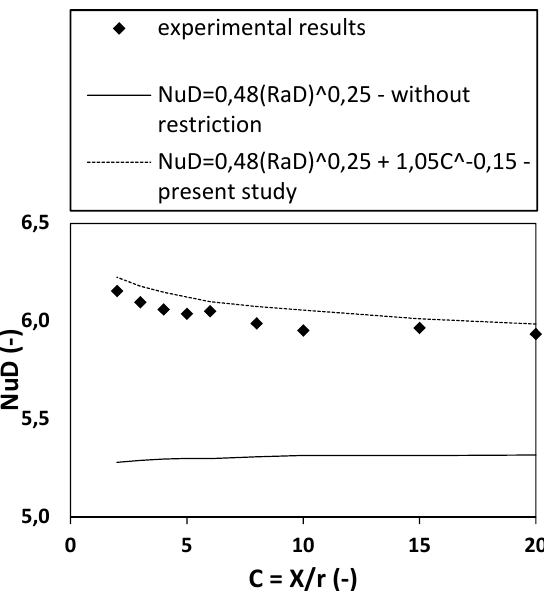
Fig. 10. Correlation between average Nusselt number versus confinement ratio for smallest q = 159 W/m